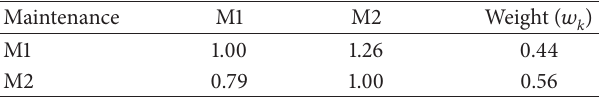
Table 7: The results of pair-wise comparison for subprecursors of Maintenance.